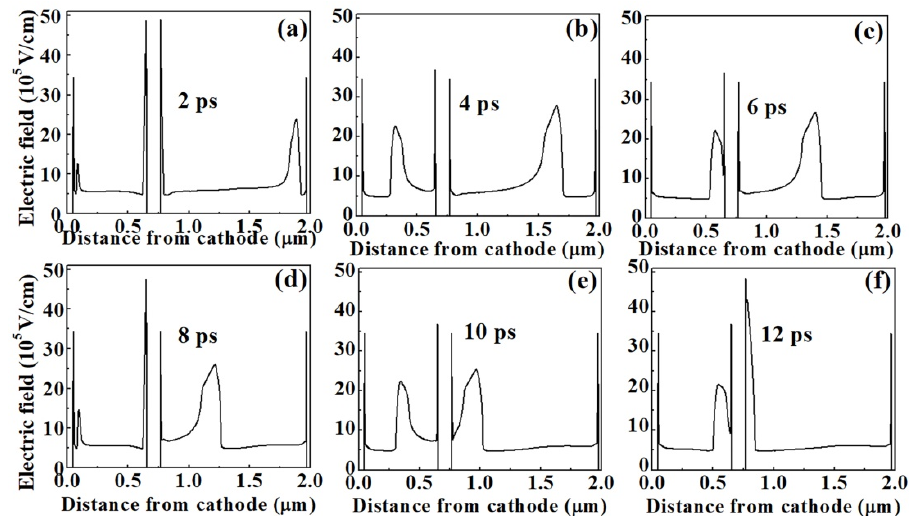
Figure 10. ( a – f ) The electric field profiles derived at the same time step in one oscillation period in the grooved-anode diode as L a = 1.0 µm and L b = 2.0 µm.